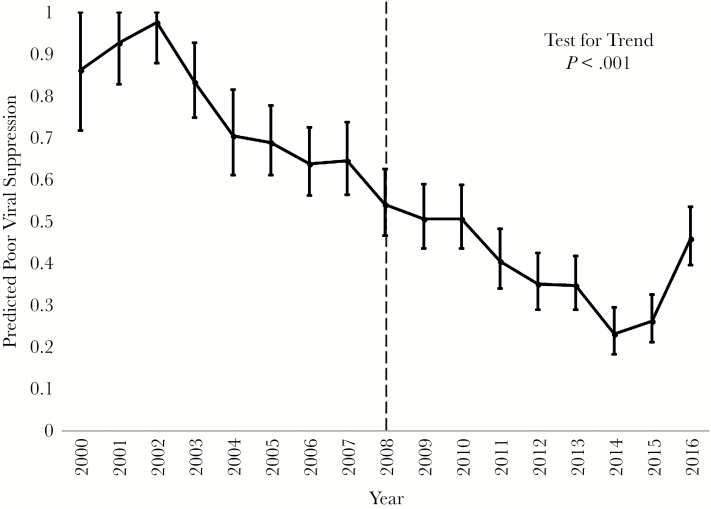
Predicted poor viral suppression by year of study. Circles represent point estimates for predicted poor viral suppression, and whiskers represent the predictive margins for poor viral suppression after the multivariable regression model. In 2008, HIV treatment guidelines changed to recommend continuation of antiretroviral therapy after delivery, as indicated by the dotted line [25].